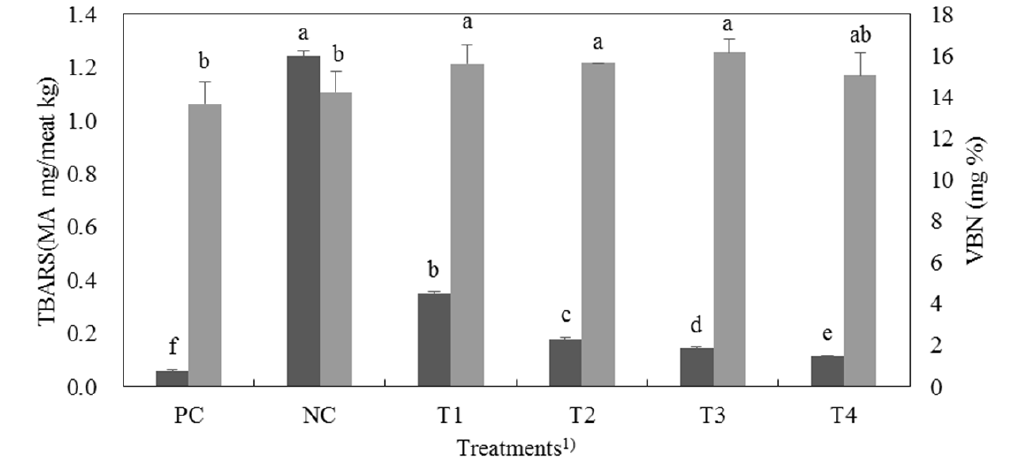
Figure 1. TBARS ( ) and VBN ( ) values of cured pork loin with natural nitrite source from FSC. TBARS, Thiobarbituric acid reactive substances; VBN, volatile basic nitrogen; FSC, fermented Swiss chard; MDA, malondialdehyde. 1) PC, positive control, 120 ppm nitrite; NC, negative control, nitrite-free; T1, FSC solution:water = 10:30; T2, FSC solution:water = 20:20; T3, FSC solution:water = 30:10; T4, FSC solution:water = 40:0. a-f Different letters on top of the column mean significant difference between treatments